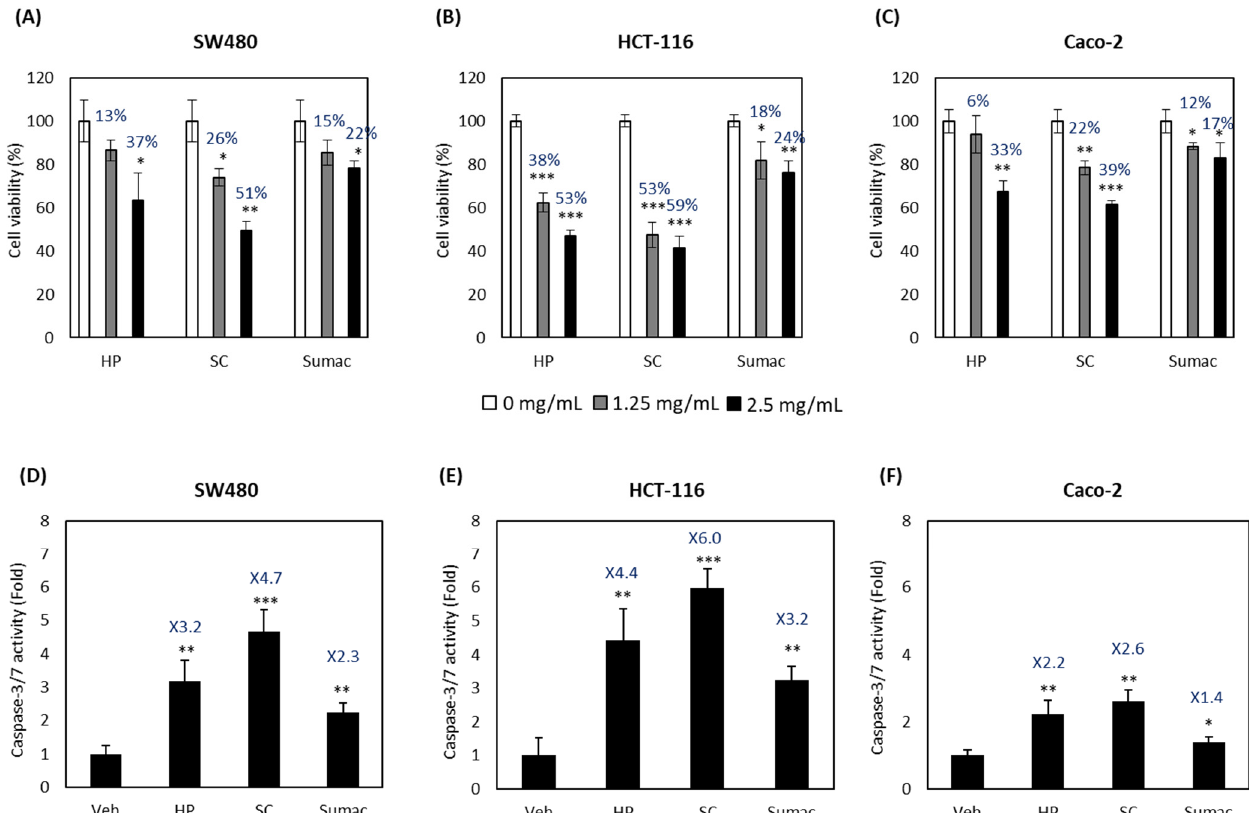
Figure 1. High phenolic sorghum bran extracts repress the proliferation and induce the apoptosis of human colon cancer cells. ( A – C ) Three human colon cancer cells, SW480 ( A ), HCT-116 ( B ) and Caco-2 ( C ) cells were treated with 0, 1.25 and 2.5 mg/mL of sorghum bran extracts (HP, SC and Sumac) for 24 h and cell proliferation was measured using MTT assay. ( D – F ) SW480 ( D ), HCT-116 ( E ), and Caco-2 ( F ) cells were treated with 2.5 mg/mL of sorghum bran extracts (HP, SC and Sumac) for 24 h and apoptosis was measured using caspase 3/7 enzyme assay kit (Promega). Values are the mean ± SD (n = 3). Significant differences between the vehicle- and sorghum bran extract-treated groups are indicated as * p < 0.05, ** p < 0.01, *** p < 0.001.